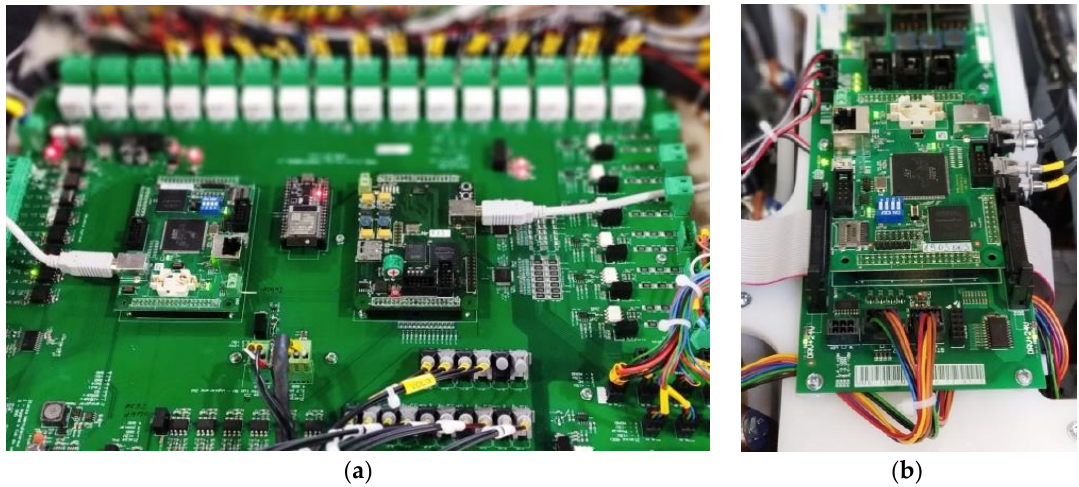
Figure 18. MASTER controller board consisting of main ADSP-21363 based control card and the auxiliary STM32F407IGT6 Arm Cortex based control card ( a ); one of nine STM32F407IGT6 Arm Cortex based SLAVE controller boards controlling nine 4QC-DAB-DC/AC power electronic cells ( b